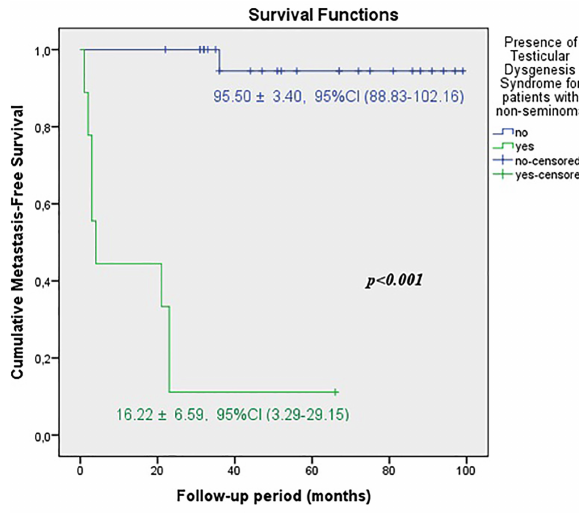
Figure 4B - Kaplan-Meier plots of metastasis-free survival according to presence of Testicular Dysgenesis Syndrome for patients with non-seminoma.